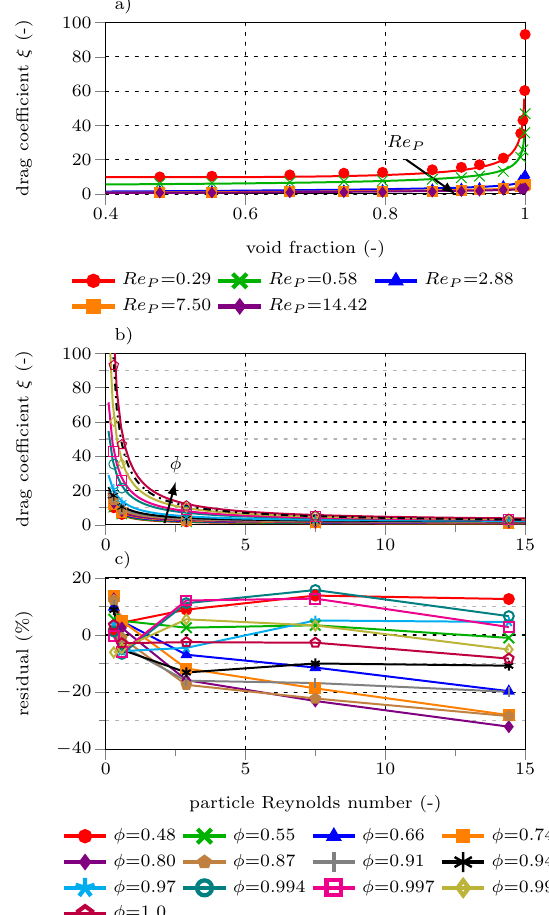
Figure 12. Comparison of drag coefficient correlation given by Equation (20) ( ) with simulation data ( ) and the drag coefficient according to Brauer [62] ( ) versus the cluster void fraction ( a ) and particle Reynolds number ( b ). The relative errors of Equation (20) compared to CFD-simulated data is presented in ( c